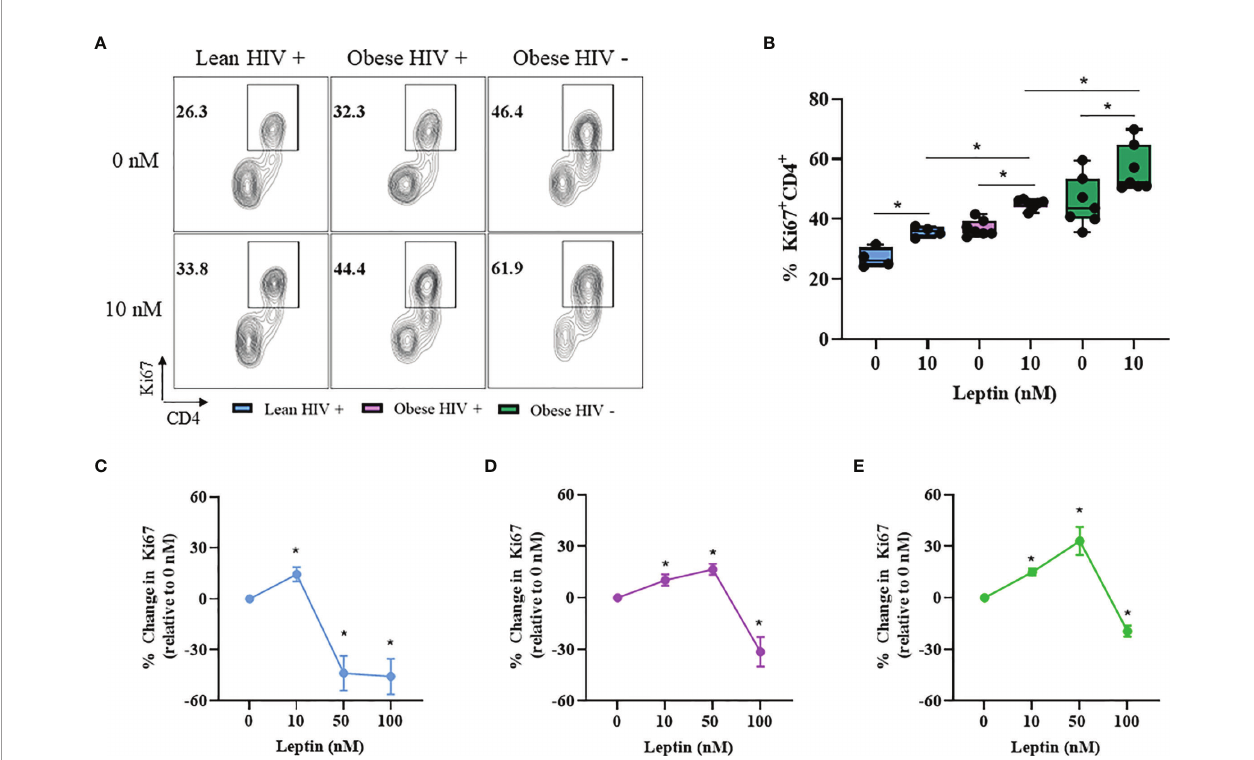
FIGURE 4 | Leptin increased CD4 + T cell proliferation in obese compared to lean PLWH. PBMCs from obese and lean PLWH, as well as obese HIV negative controls, were pre-treated with recombinant leptin at the indicated concentrations for 48 hours, then stimulated with anti-CD3/CD28/CD49d for 2 days. (A) Representative fl ow gating of Ki67 + CD4 + T cells in obese and lean PLWH and HIV negative controls after 0 or 10 nM leptin treatment. (B) Quanti fi cation of the percentage of Ki67 + CD4 + T cells under 0 or 10 nM leptin treatment. Quanti fi cation of the percentage change in Ki67 expression (relative to 0 nM conditions) in CD4+ T cells from (C) lean PLWH, (D) obese PLWH and (E) obese HIV negative control following 0, 10, 50 or 100 nM leptin treatment. In (B) , Wilcoxon-matched pairs rank signed tests were used to compare 0 and 10 nM values for each person. Mann-Whitney tests were used to compare 10 nM leptin treatment between groups. In (C – E) , Kruskal-Wallis tests were used to compare the relative change compared to vehicle treatment in each metabolic group. n = 4-7 people per group. * p < 0.05 was considered statistically signi fi cant. Data shows one representative experiment repeated two